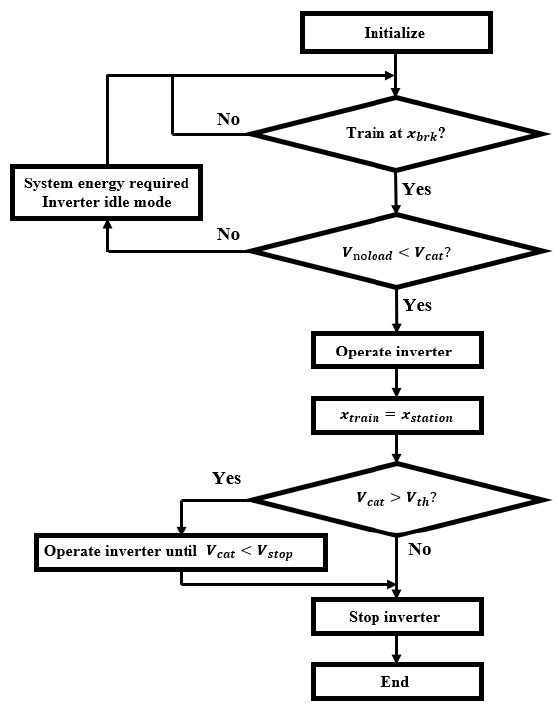
Figure 9. Brake location based regenerative inverter operation